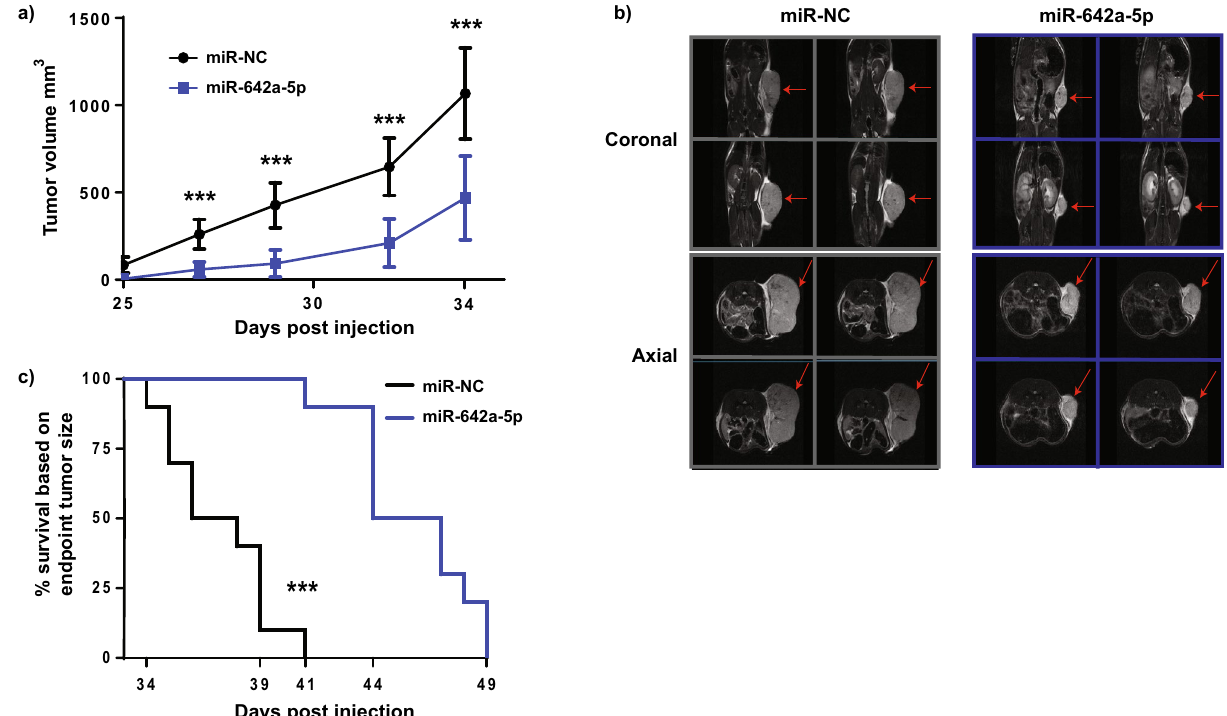
Figure 1. miR-642a-5p inhibits PCa xenograft tumor growth and increases survival. Subcutaneous xenograft study of 22Rv1 PCa cells transiently overexpressing miR-642a-5p or miR-NC in NSG mice (10 per group). ( a ) Xenograft tumor volumes in mice measurable from day 25 to day 34. CI = 0.95; *** p < 0.0002. ( b ) Coronal and axial MRI images of day 34 representative mice from both miR-NC and miR-642a-5p xenograft groups. Red arrows indicate tumor. ( c ) Tumor size end point Kaplan–Meier survival curve of miR-642a-5p versus miR-NC xenograft mice. Log-rank (Mantel-Cox) Test *** p < 0.0001, Gehan–Breslow–Wilcoxon Test *** p <